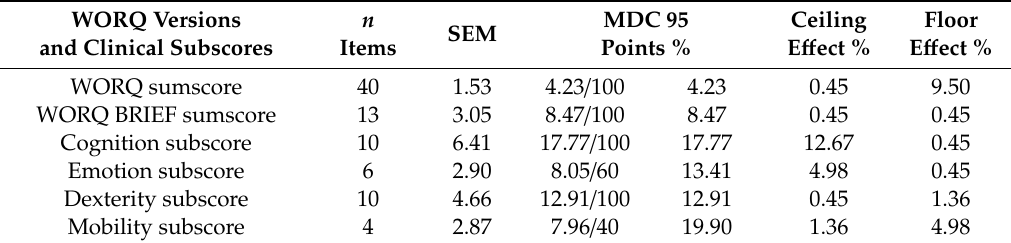
Table 4. Minimal detectable change and ceiling and bottom e ff ect.